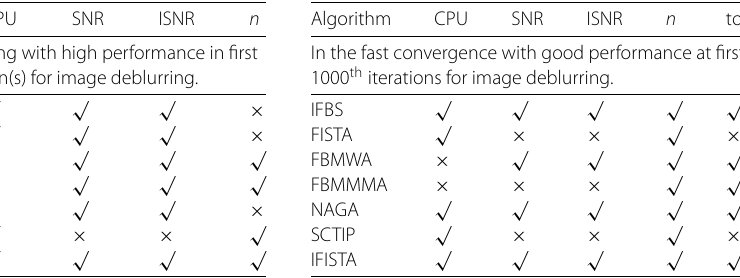
Algorithm In the fast convergence with good performance at first 1000 th iterations for image